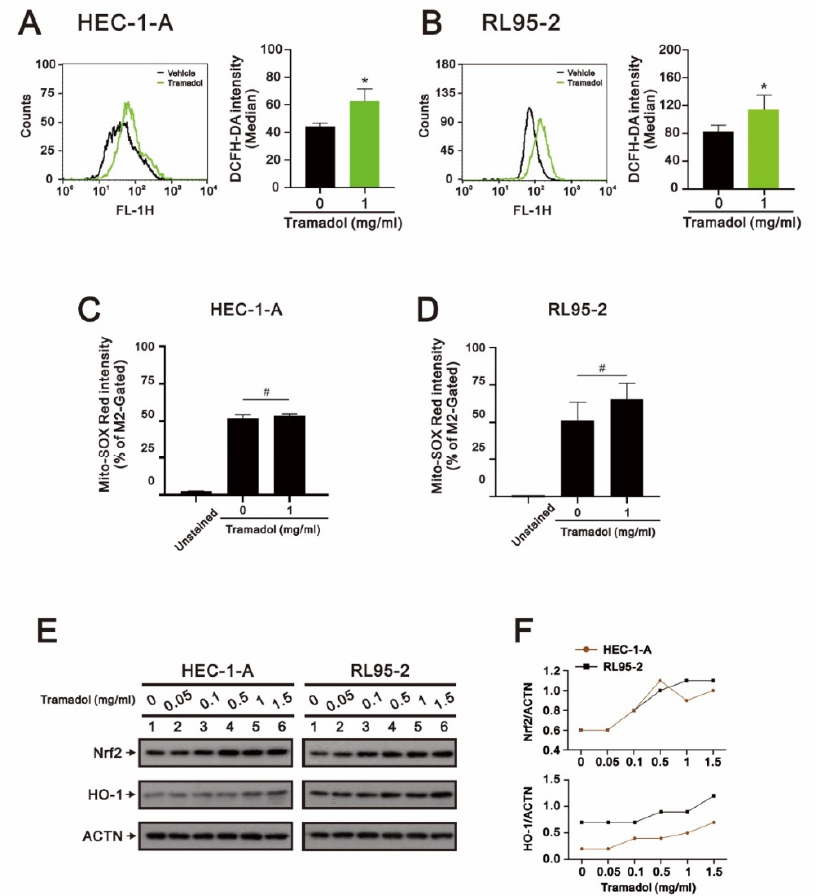
Figure 6. Effects of tramadol on ROS levels of human endometrial cancer cells. ( A – D ) HEC-1-A and RL95-2 cells were treated with tramadol (0 and 1 mg/mL) for 2 h. Intracellular ROS and mtROS levels were assessed using DCFH-DA and MitoSOX Red staining with flow cytometry. Bars depict the mean ± SD of three independent experiments. Student’s t -tests were performed, and the results compared with the vehicle. # p > 0.05 and * p < 0.05 (Student’s t -test). ( E ) HEC-1-A and RL95-2 cells were treated with tramadol (0, 0.05, 0.1, 0.5, 1, and 1.5 mg/mL) for 4 h. Cell lysates were subjected to Western blot analysis using antibodies against the indicated proteins. ACTN was the protein loading control. ( F ) The protein bands from ( E ) were quantified through pixel density scanning and evaluated using ImageJ, version 1.44a (http://imagej.nih.gov/ij/) (accessed on 12 December 2022). The ratios of protein/ACTN, including Nrf2 and HO-1, were